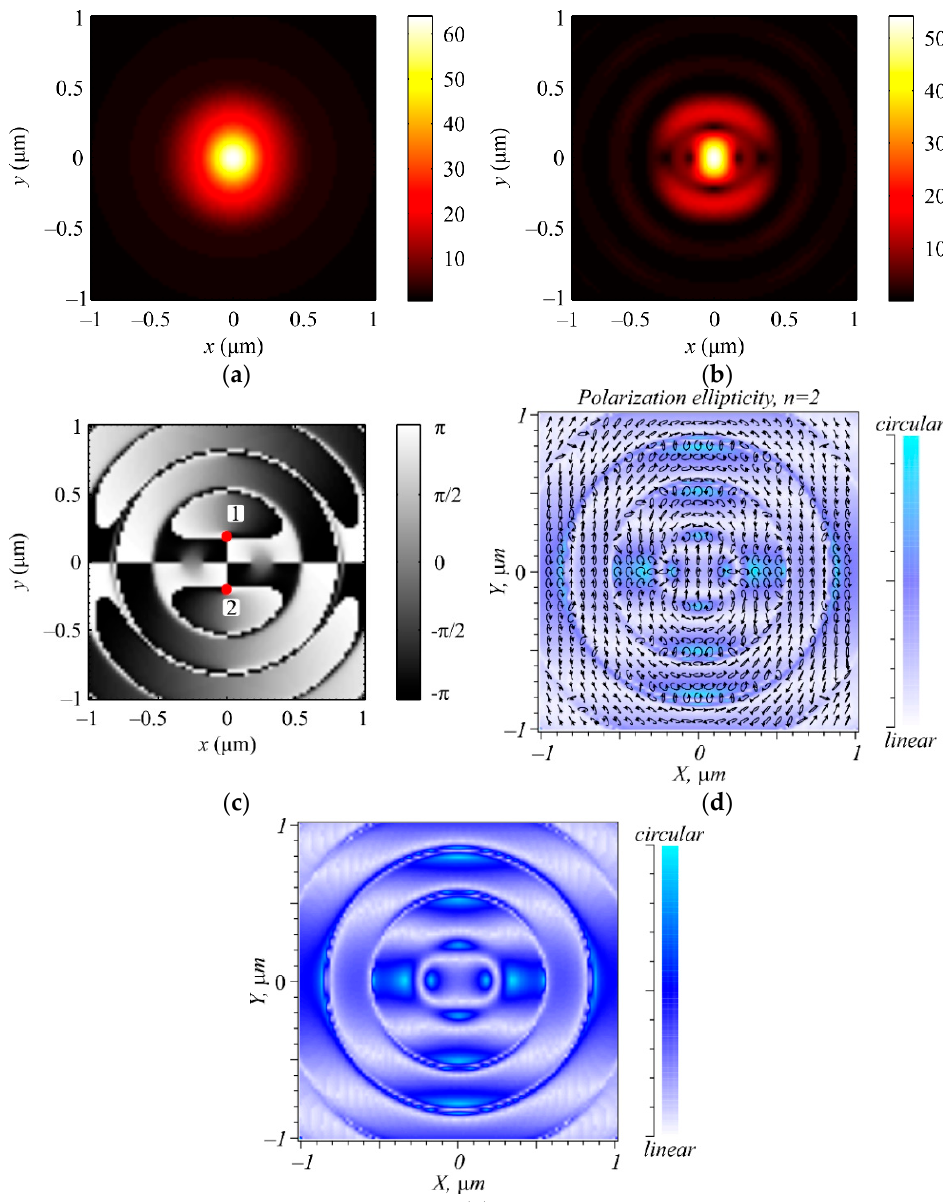
Figure 2. ( a ) An intensity I = Ix + Iy + Iz , ( b ) amplitude, and ( c ) phase of a complex Stokes field (20) when field (1) at n = 2. ( d ) Pattern of elliptic polarization at the focus, and ( e ) pattern of points with circular, elliptic, and linear polarization.